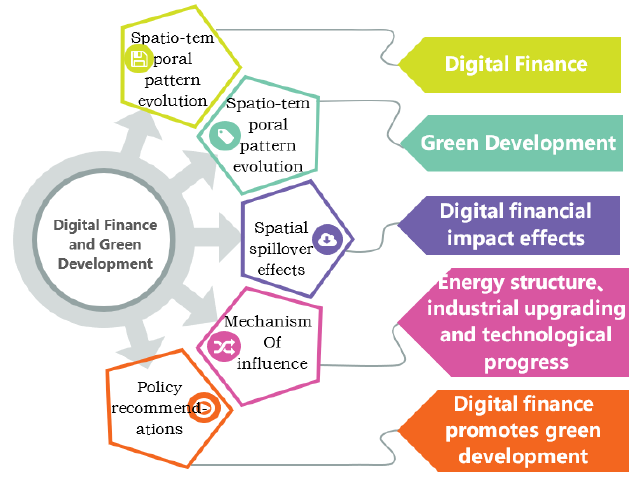
Figure 1. The research framework.